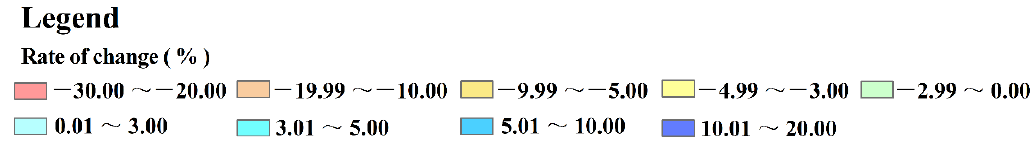
Figure 9. The variation of river characteristic parameters in provinces of the Yellow River Basin during the period 2000–2010 and 2010–2020. The change rate of river density in the period ( a ) 2000–2010 and ( b ) 2010–2020; the change rate of capacity dimension D 0 in the period ( c ) 2000–2010 and ( d ) 2010–2020; the change rate of information dimension D 1 in the period ( e ) 2000–2010 and ( f ) 2010–2020; the change rate of multifractal spectrum width ∆ α in the period ( g ) 2000–2010 and ( h ) 2010–2020; the change rate of multifractal spectrum difference ∆ f in the period ( i ) 2000–2010 and ( j )